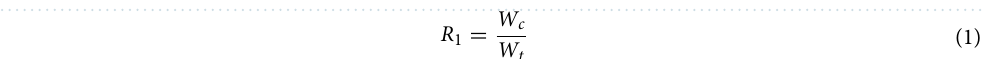
Figure 3. Artificial watering quantity, daily rainfall and average temperature during the experiment